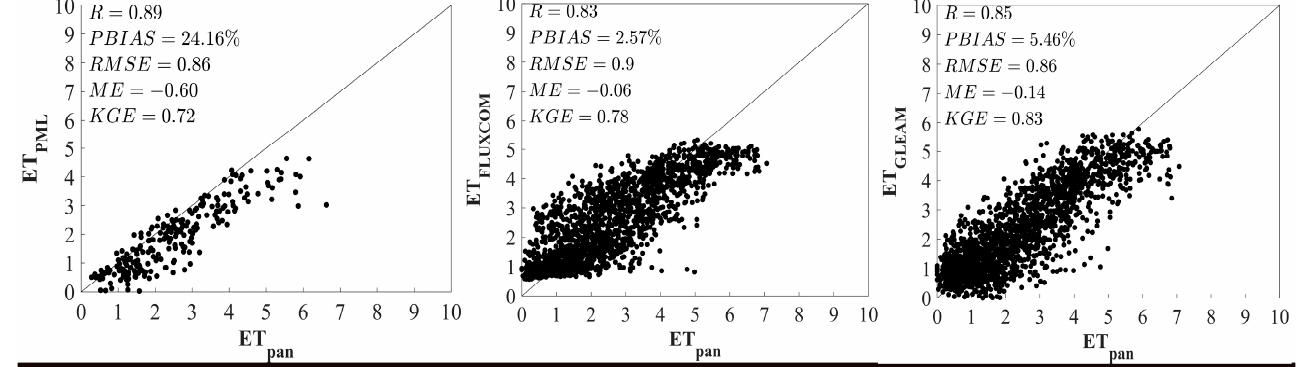
Figure 3. Comparison of the daily ET data derived from three remote sensing-based datasets with in situ observations of pan evaporation.